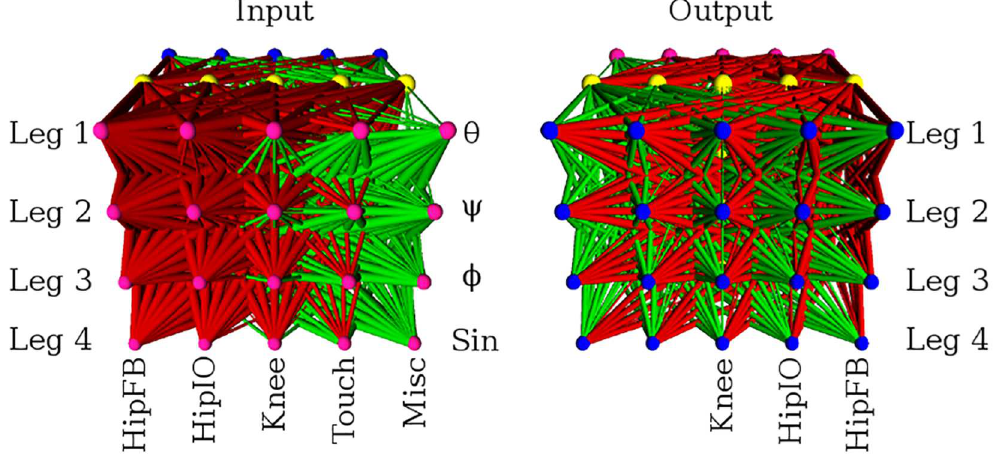
Fig 15. The configuration of the ANN controller evolved for the quadruped robot experiment. θ , ψ , and ϕ are the pitch, yaw, and roll angles of the main body respectively. Red links are inhibitory, green links are excitatory, and link weight magnitude is indicatedby the thickness of the link. Adapted from